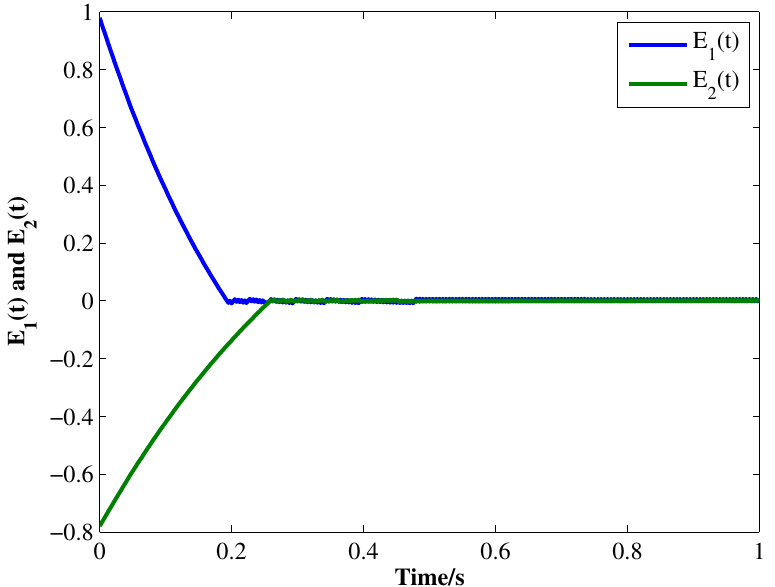
Figure 8. Synchronization errors E 1 ( t ) and E 2 ( t ) between systems (33) and (34) under ETC condition (39) with η = 0.5.